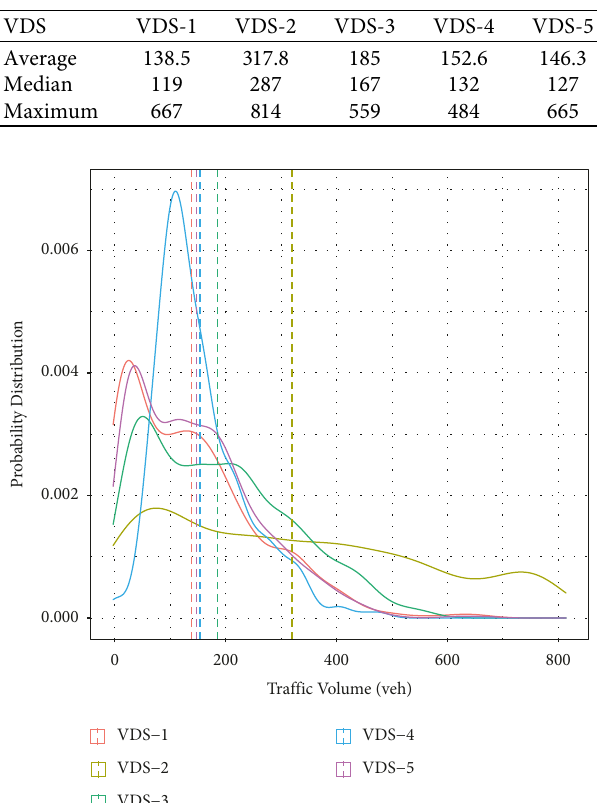
Table 2: Statistical property of 15-minute traffic flow of each VDS (unit: Veh).